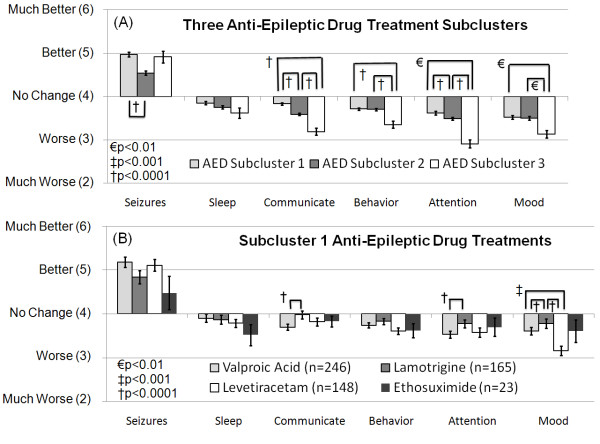
Rating for subclusters of anti-epileptic drug treatments for clinical seizures. (A) Anti-epileptic drug treatment subcluster 1 was perceived as improving seizures better than subcluster 2 and worsened several other clinical factors less than subclusters 2 and 3. (B) The perceived effect on seizures was not different across the four anti-epileptic drug treatments in subcluster 1. Out of the four treatments in subcluster 1, lamotrigine appeared to worse several other clinical factors, such as communication, attention and mood less than other treatments.